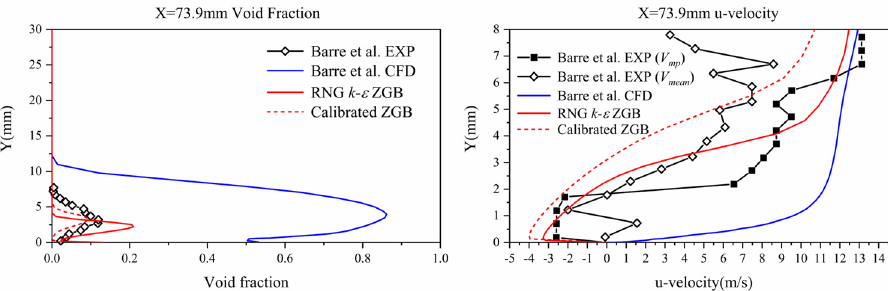
Figure 5. Void fraction and u-velocity at X = 73.9 mm with the calibrated ZGB model coefficients .